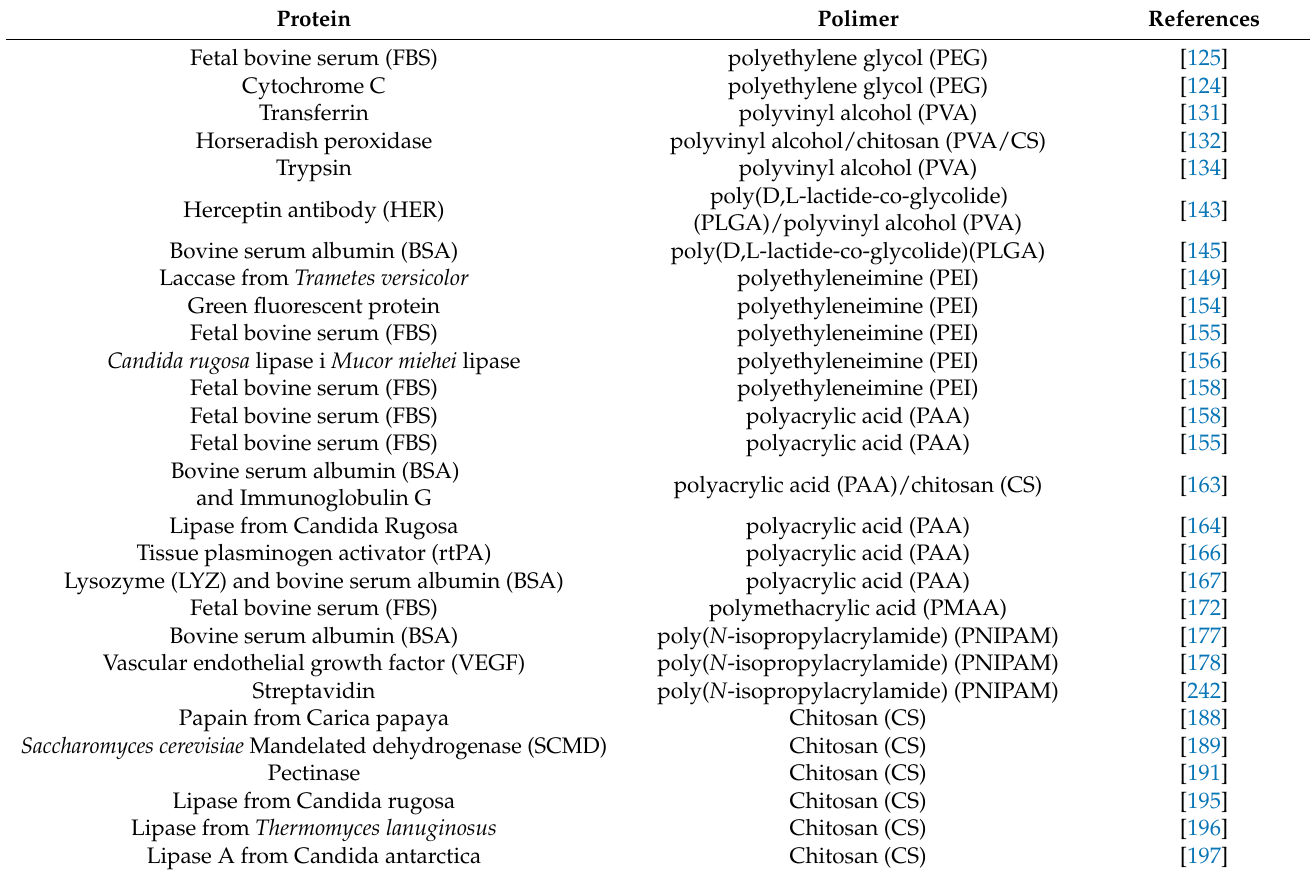
Table 4. List of proteins immobilized on magnetic nanoparticles coated with polymers described in the literature.